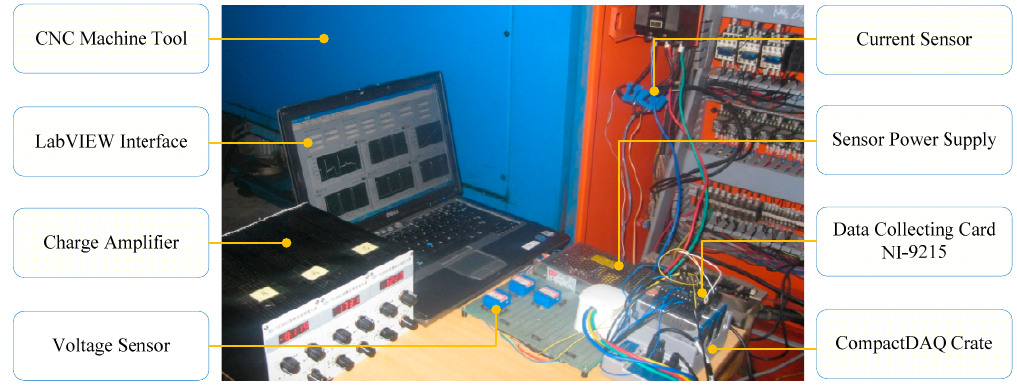
Figure 10. Experimental setup of energy acquisition system.